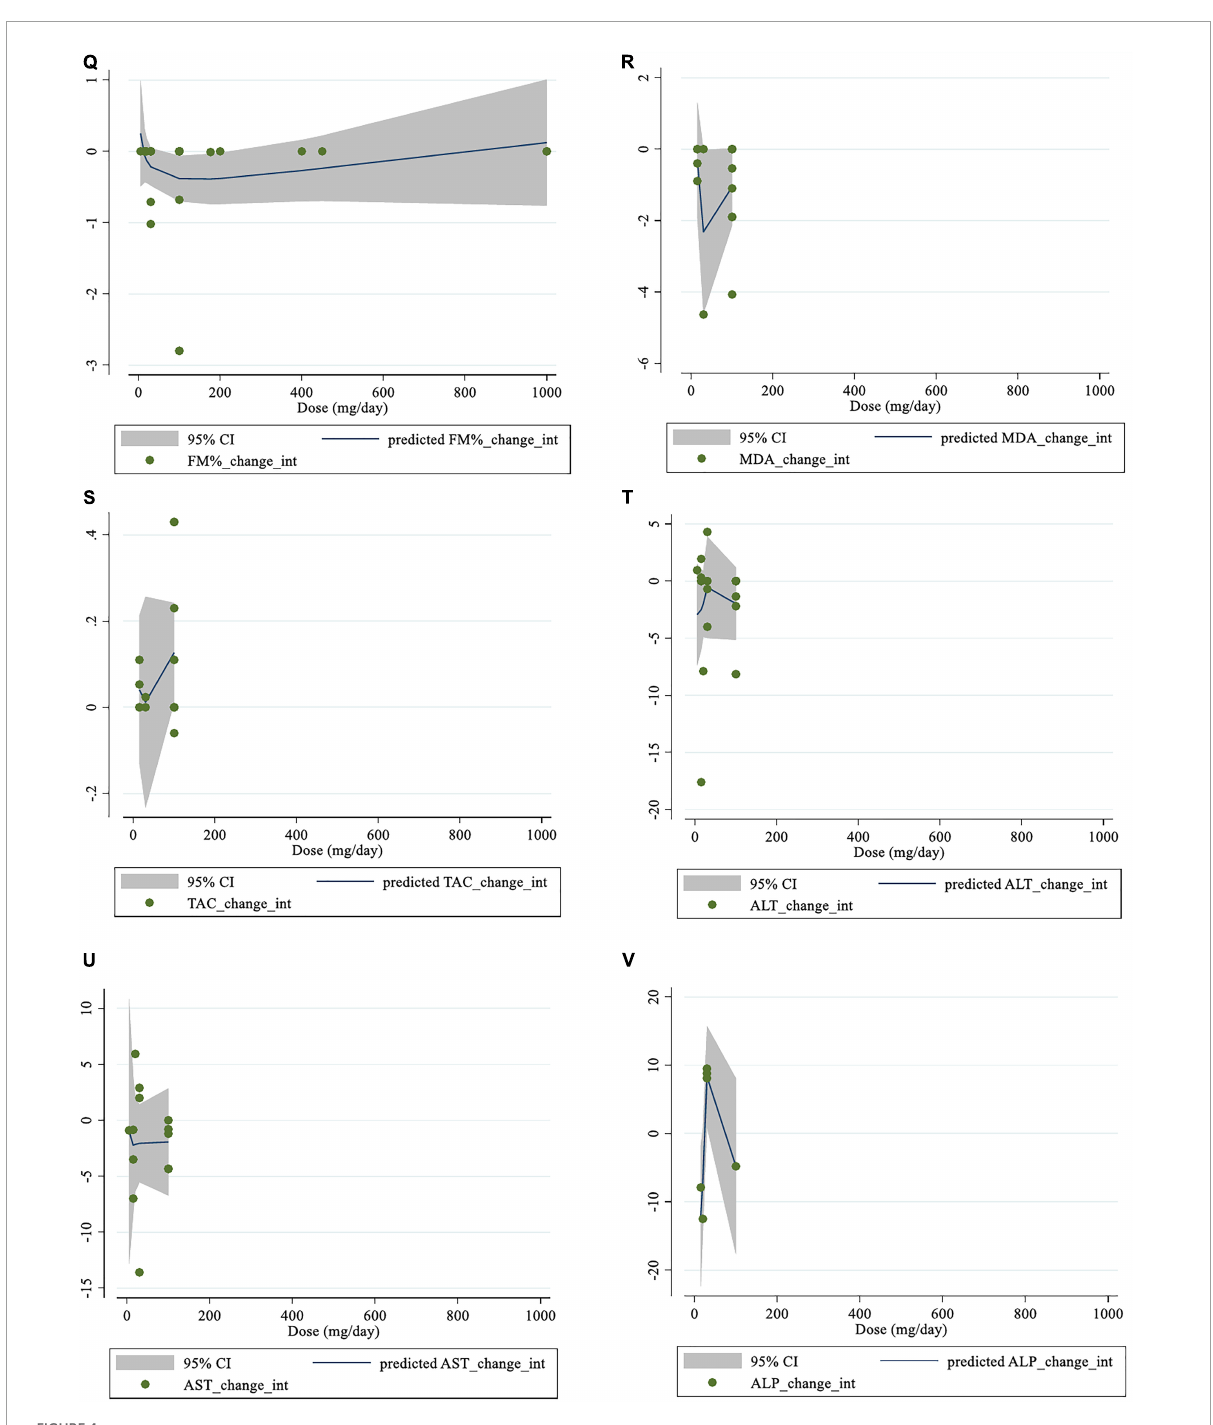
FIGURE4 Non-linear dose-response relations between saffron consumption and absolute mean differences. Dose-response relations between dose (mg/day) and absolute mean differences (A) TG (mg/dl); (B) TC (mg/dl); (C) LDL (mg/dl); (D) HDL (mg/dl); (E) FBG (mg/dl); (F) Insulin (miu/ml); (G) HbA1c (%); (H) HOMA-IR; (I) SBP (mmHg); (J) DBP (mmHg); (K) CRP (mg/l); (L) ; IL-6 (pg/ml); (M) TNF- α (pg/ml); (N) weight (kg); (O) BMI (kg/m 2 ); (P) WC (cm); (Q) FM (%); (R) MDA (uM/L); (S) TAC (mM/L); (T) ALT (U/L); (U) AST (U/L) and (V) ALP (U/L). TG, triglyceride; TC, total cholesterol; LDL, low-density lipoprotein; HDL, high-density lipoprotein; FBG, fasting blood glucose; HOMA-IR, homeostasis model assessment for insulin resistance; HbA1c, hemoglobin A1c; CRP, C-reactive protein; IL-6, interleukin 6; TNF- α , tumor necrosis factor; TAC, total antioxidant capacity; BMI, body mass index; WC, waist circumference; FM, fat mass; ALT, alanine transaminase; AST, aspartate transaminase; ALP, alkaline phosphatase; MDA, malondialdehyde ; SBP, systolic blood pressure; DBP, diastolic blood pressure; CI, confidence interval; WMD, weighted mean